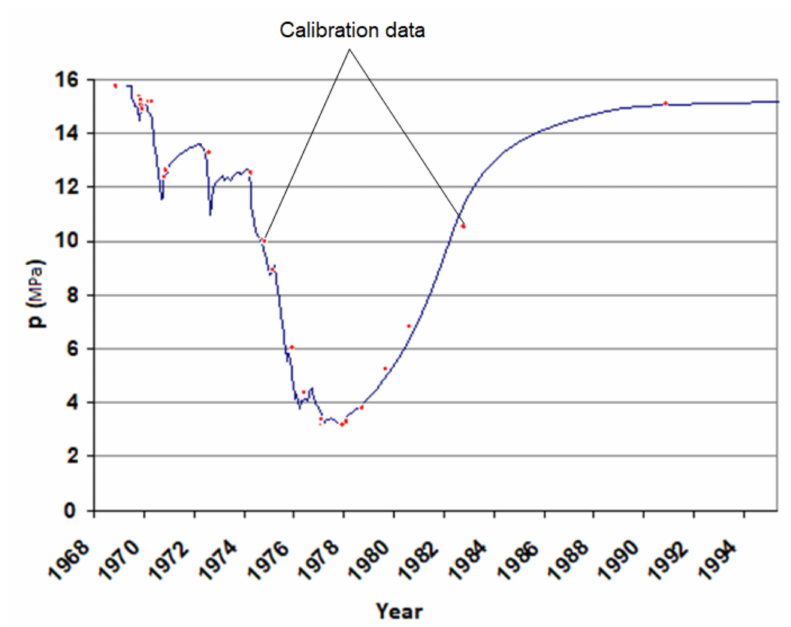
Figure 11. Pressure profile during production history of the case study reservoir at well X6. The curve declines during the production phase and increases during the shut-in phase (replenishment phase). Its continuation until present-day would provide the pore pressure field for future scenario testing. The continuous blue line represents pressure profile as a result of history match from the flow simulation. Red dots are the observed pressure data which can be used as calibration points on the pressure